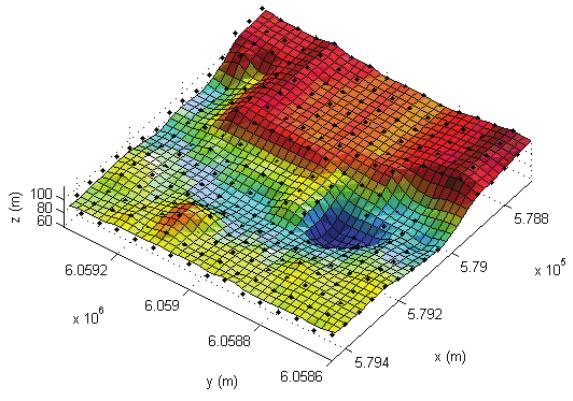
Fig. 5. Terrain model created by Geo3D program using photogrammetric data